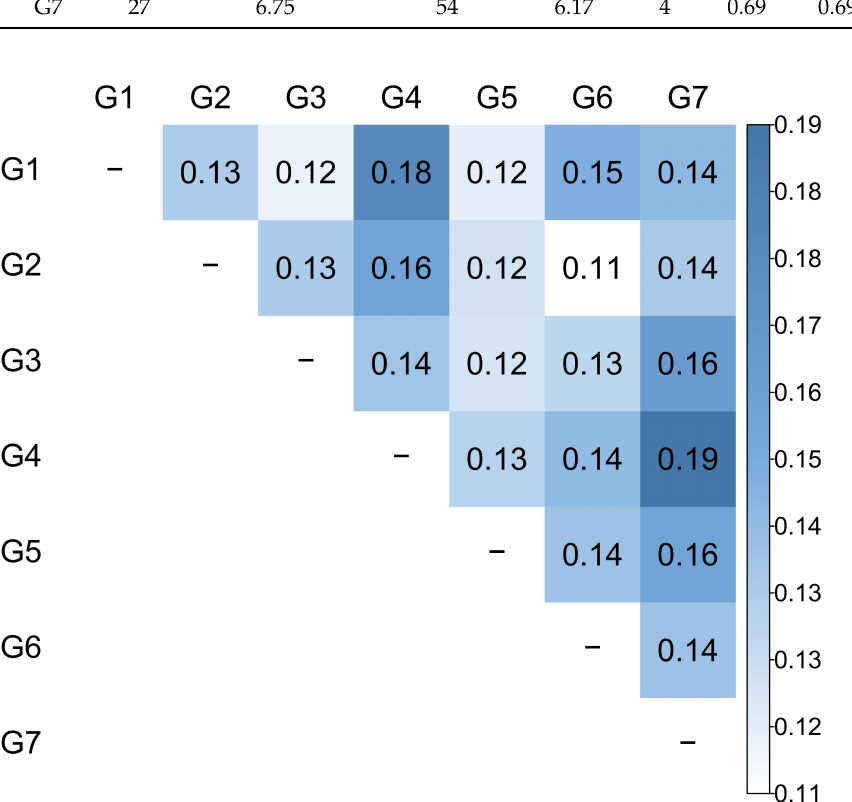
Figure 3. Weighted pairwise F ST values estimated from the seven inferred groups ( K =